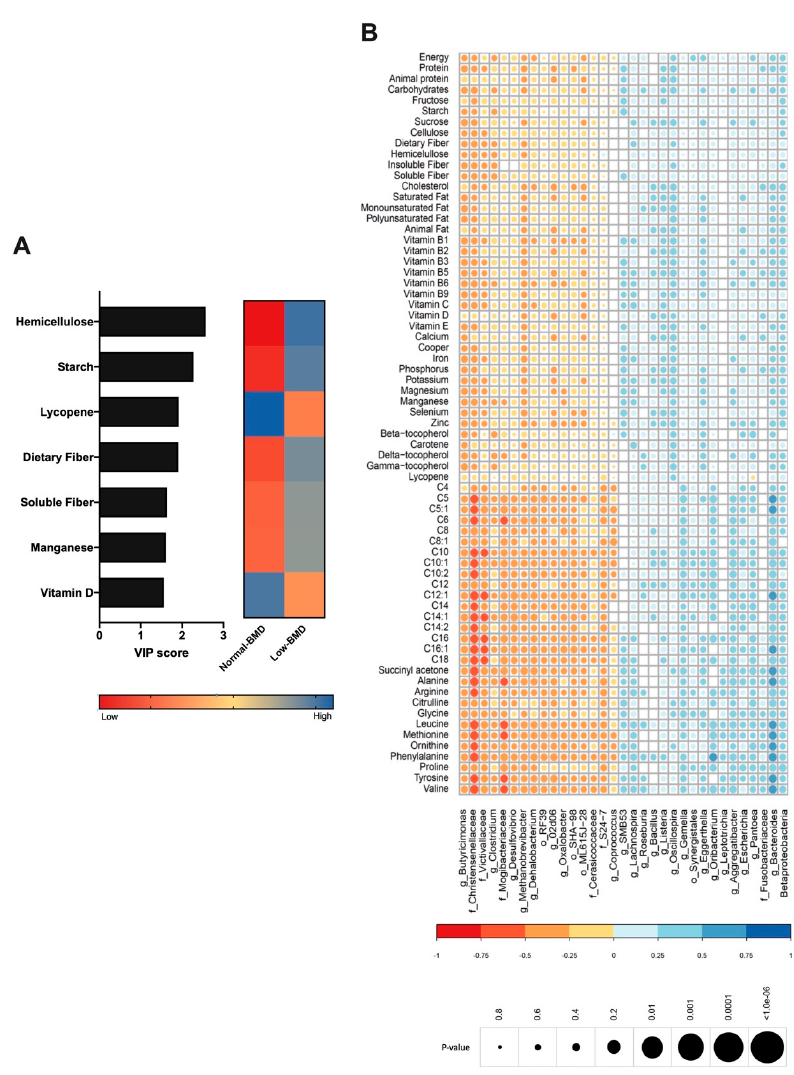
Figure 4. Contribution of dietary components to the composition of gut microbiota. ( A ) VIP analysis represents the relative contribution of nutrient consumption to the variance between normal-BMD and low-BMD. The high value of the VIP score indicates the great contribution of the nutrient consumption to the group separation. The blue and red boxes on the right indicate whether the consumption is increased (blue) or decreased (red). The low-BMD group diet was characterized by higher fiber intake, starch, and manganese consumption. The normal-BMD group was characterized by lycopene and vitamin D intake. ( B ) Correlation heatmap. Blue and red color indicates an increase and decreased correlation, respectively. The size of each dot was associated with the p -value, where a big circle represents a smaller p -value. Lachnospiraceae abundance was positively correlated with fiber consumption and in a negative manner with vitamin D intake. Calcium consumption was negatively correlated with Butyricimonas . Lycopene consumption was decreased in the low-BMD group, and positively correlated with Oscillospira and negatively correlated with Pantoea genus abundance.